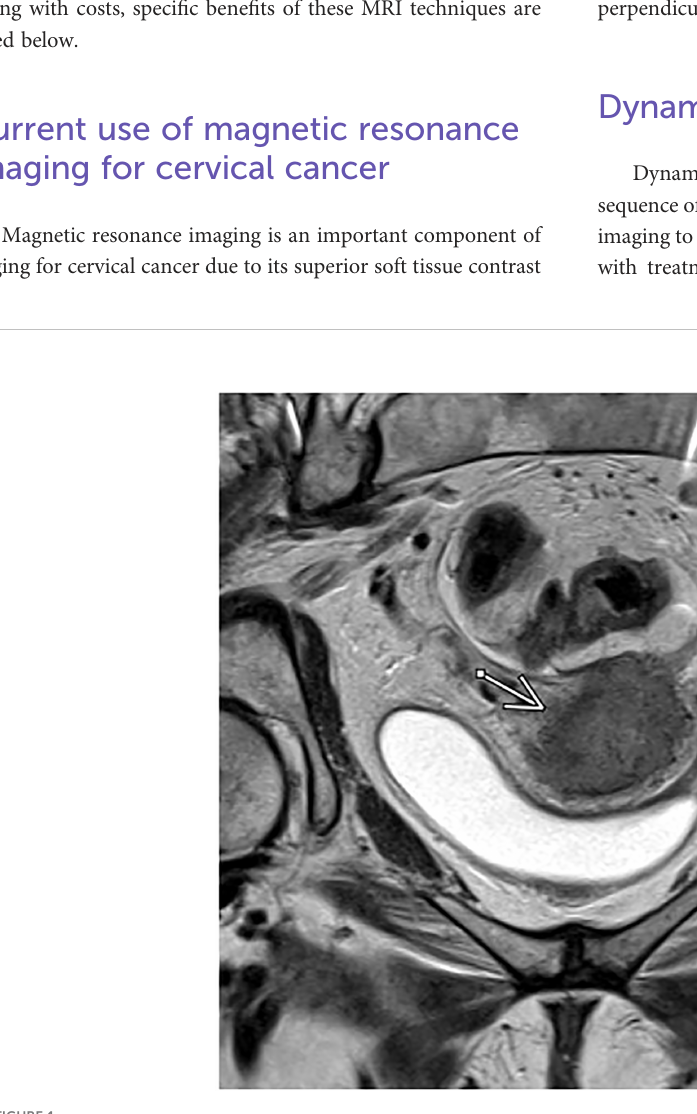
FIGURE 1 Axial T2-weighted MRI in a patient with FIGO IIIC1, pathologic T2 squamous cell carcinoma of the